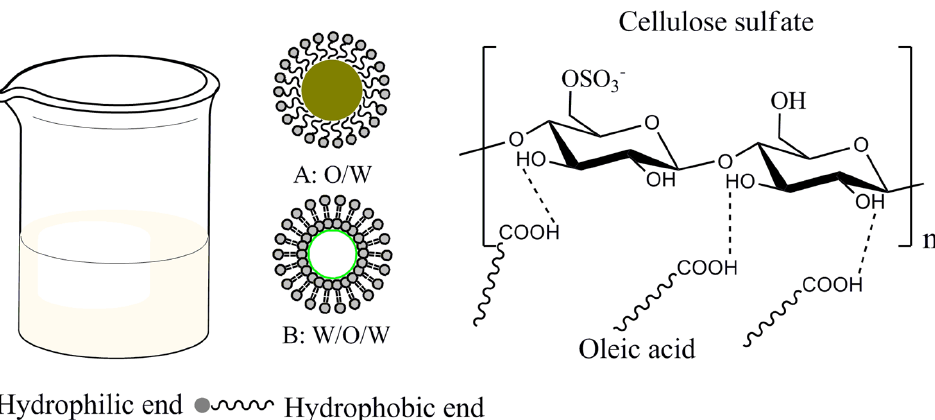
Graph 1. The schematic for emulsion of oleic acid, cellulose sulfate, glycerol and